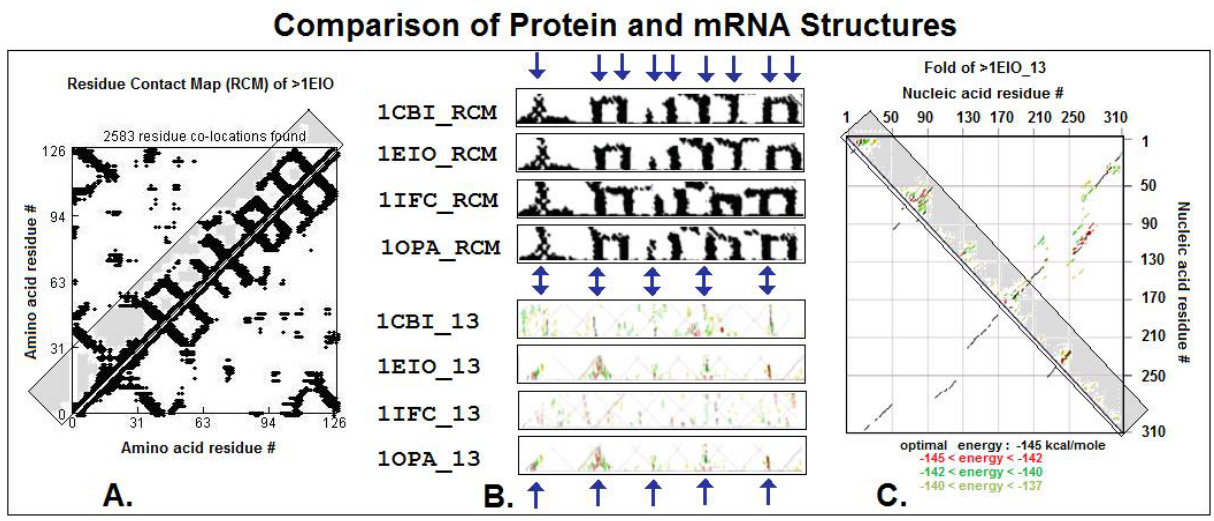
Figure 4. Comparison of the protein and mRNA structures (modified from [47]). Residue contact maps (RCM) were obtained from the PBD files of four protein structures (1CBI, 1EIO, 1IFC, 1OPA) using the SeqX tool (example on the left side of the figure). Energy dot plots (EDP) for the coding sequences were obtained using the mfold tool (example on the right side of the figure). The left diagonal portions of these two maps (in gray boxes in the examples) are compared in the central part of the figure. RNA subsequences containing only the 1st and 3rd codon letters (13) are compared. The black dots in the RCMs indicate amino acids that are within 6 Å of each other in the protein structure. The colored (grass- like) areas in the EDPs indicate the energetically most likely RNA interactions (color code in increasing order: yellow, green red, black). The blue arrows indicate the main similarities between the protein and nucleic acid